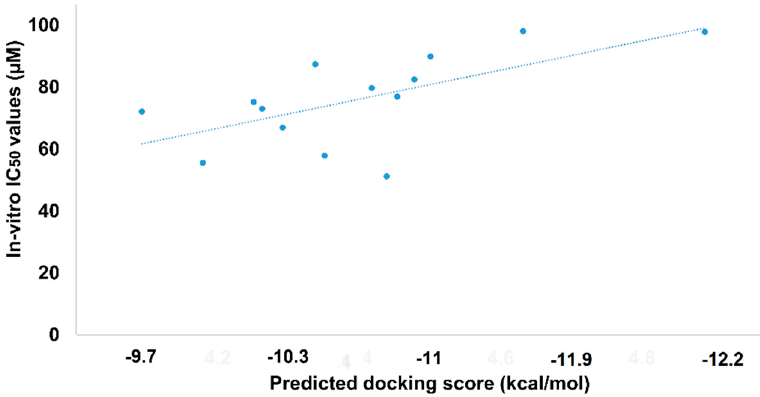
Figure 15. Correlation plot between docking score (kcal/mol) and experimental potency. A time dependent linear response of cell death was observed at single dose concentration. The compounds showed good results and caused % growth reduction but the derivatives 7c , 7g , 7h , 7j , 7l , 7k and 7m showed maximum cell death justifying the computational studies where these compounds were found to be the best inhibitors of VEGFR-2 and also EGFR. The single concentration cisplatin was used as positive control. The results were calculated by comparing with the total activity control (without inhibitor) i.e., un-treated cells. The % viability graph was generated via graph pad Prism software and is given in the Figure 16.